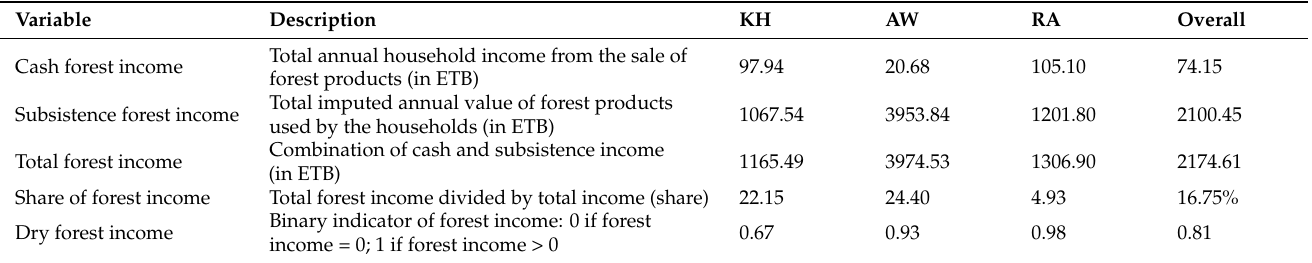
Table 6. Measures of forest income among 170 households of the three districts of Tigray Region, Ethiopia.